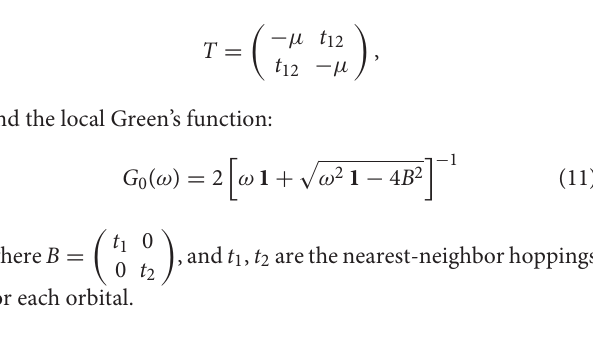
0. (Right panel) Varying t 12 for U =